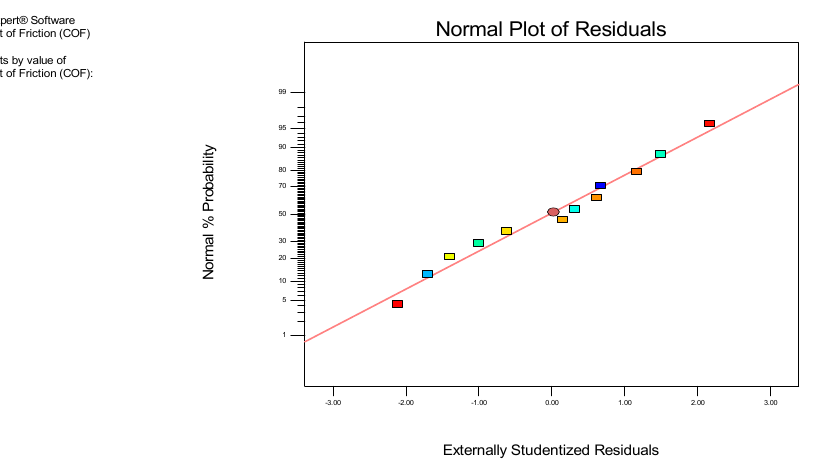
Figure 2. The normal probability plot of the COF for the MoS 2 nanolubricants. The experimental outcome of the COF for the MoS 2 nanolubricants was fitted to a quadratic polynomial equation, as shown in Equations (2) and